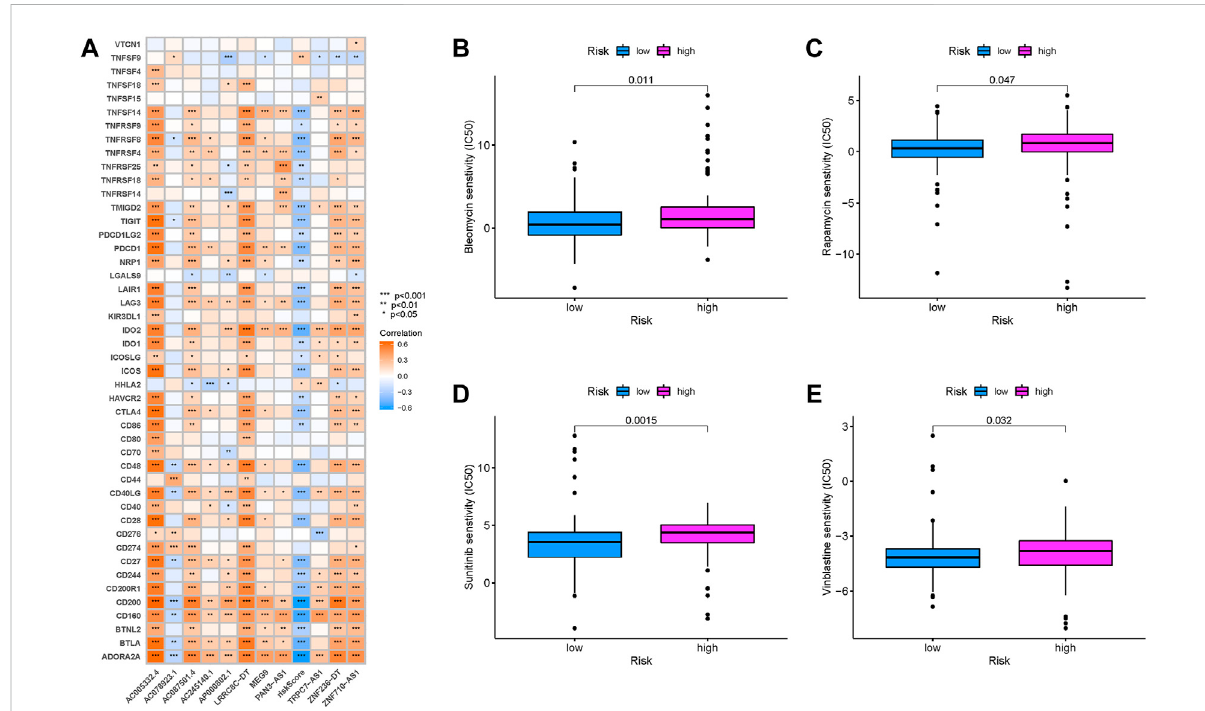
FIGURE 10 Prediction of immunotherapeutic response. (A) Correlation of expression level of immune checkpoint blockade genes with the risk score. Estimation of the risk score in chemotherapeutic effect. (B) Sensitivity analysis of bleomycin in patients with high- and low-risk scores. (C) Sensitivity analysis of rapamycin in patients with high- and low-risk scores. (D) Sensitivity analysis of sunitinib in patients with high- and low-risk scores. (E) Sensitivity analysis of vinblastine in patients with high- and low-risk